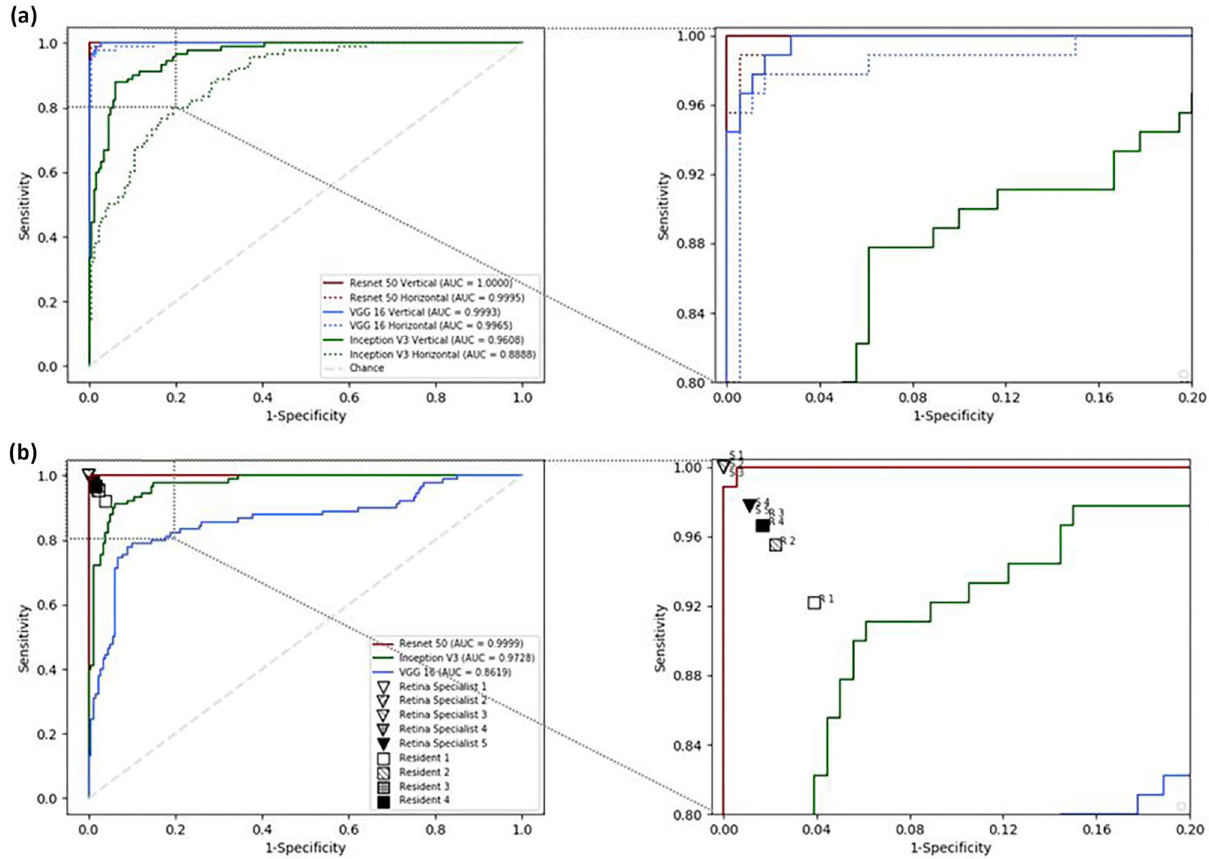
Figure 3. Comparison of the performance of the deep learning models with that of human doctors. ( a ) The receiver operating characteristic curves of three deep learning models of a single-column model. ResNet 50 demonstrate the best diagnostic performance. ( b ) The receiver operating characteristic curves of three deep learning models of the multiple-column model and the diagnostic performance of human doctors. ResNet 50 show the best diagnostic performance among the three deep learning models and had comparable performance to that of the retinal